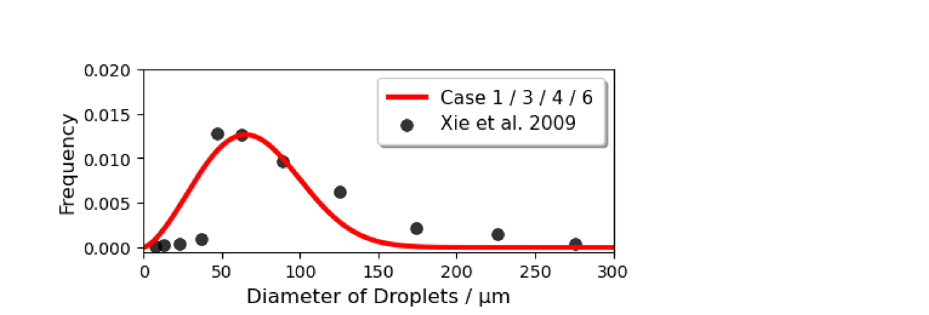
Table 3. Initial constituents of complete sputum droplets.